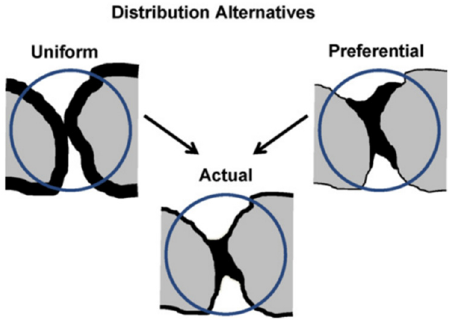
Figure 5. Illustration of calcite distribution alternatives within pore spaces [49] (Dejong et al., 2010).